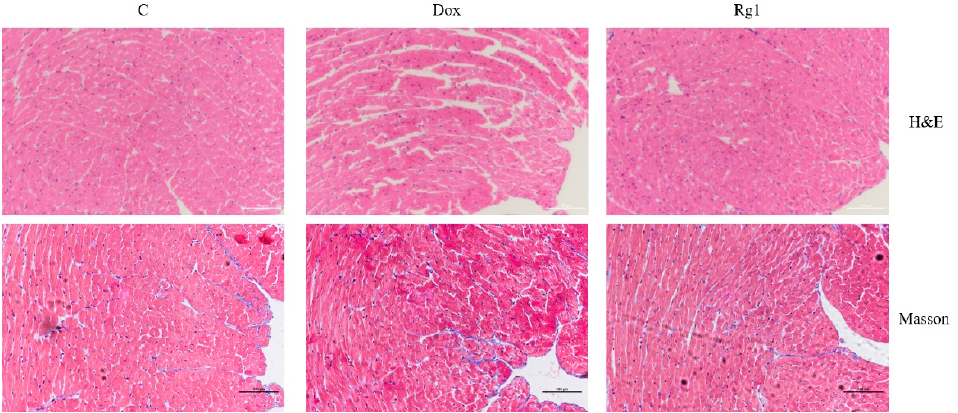
Figure 2. Protective effects of ginsenoside Rg1 on cardiac morphology and fibrosis in doxorubicin- induced cardiomyopathy. The upper panel represents images with H&E staining; the lower panel indicates cardiac fibrosis with Masson ′ s Trichrome staining. Scale bar: 100 μ m.